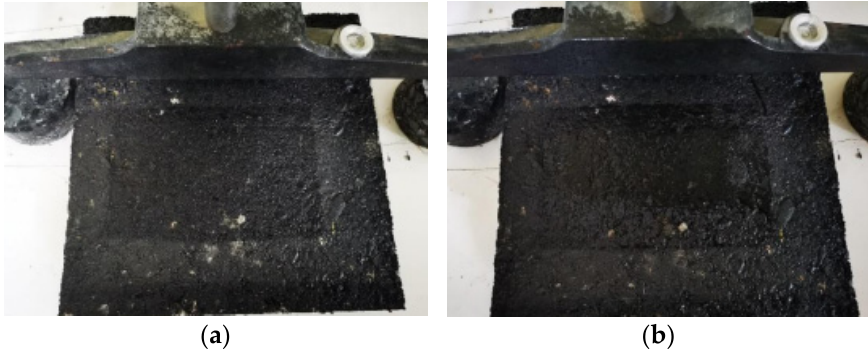
Figure 5. Specimens with water content of 5% ( a ) and 10% ( b ) respectively before adding aeolian sand.